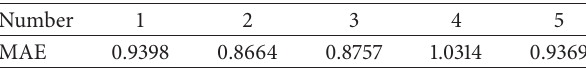
Table 7: Error of different test samples of papilionaceous dual-plane